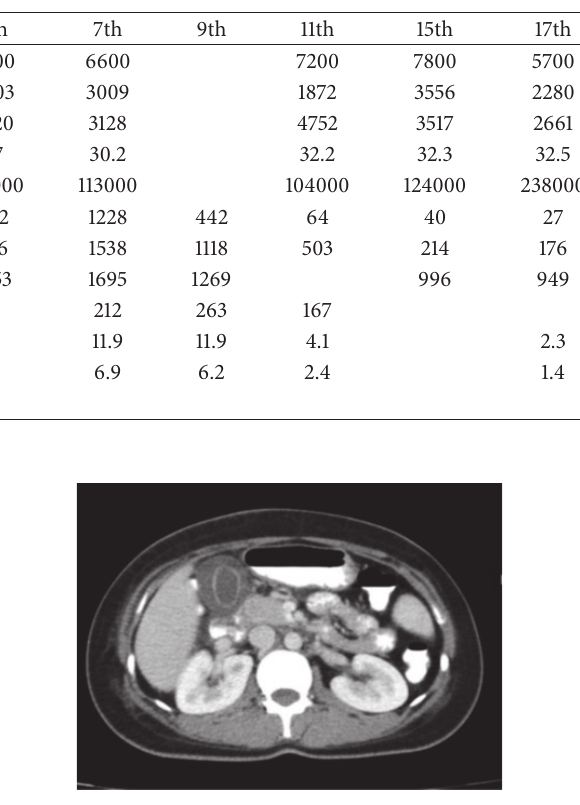
Figure 1: Abdominal CT scan representing an acalculous gallblad- der with a thick